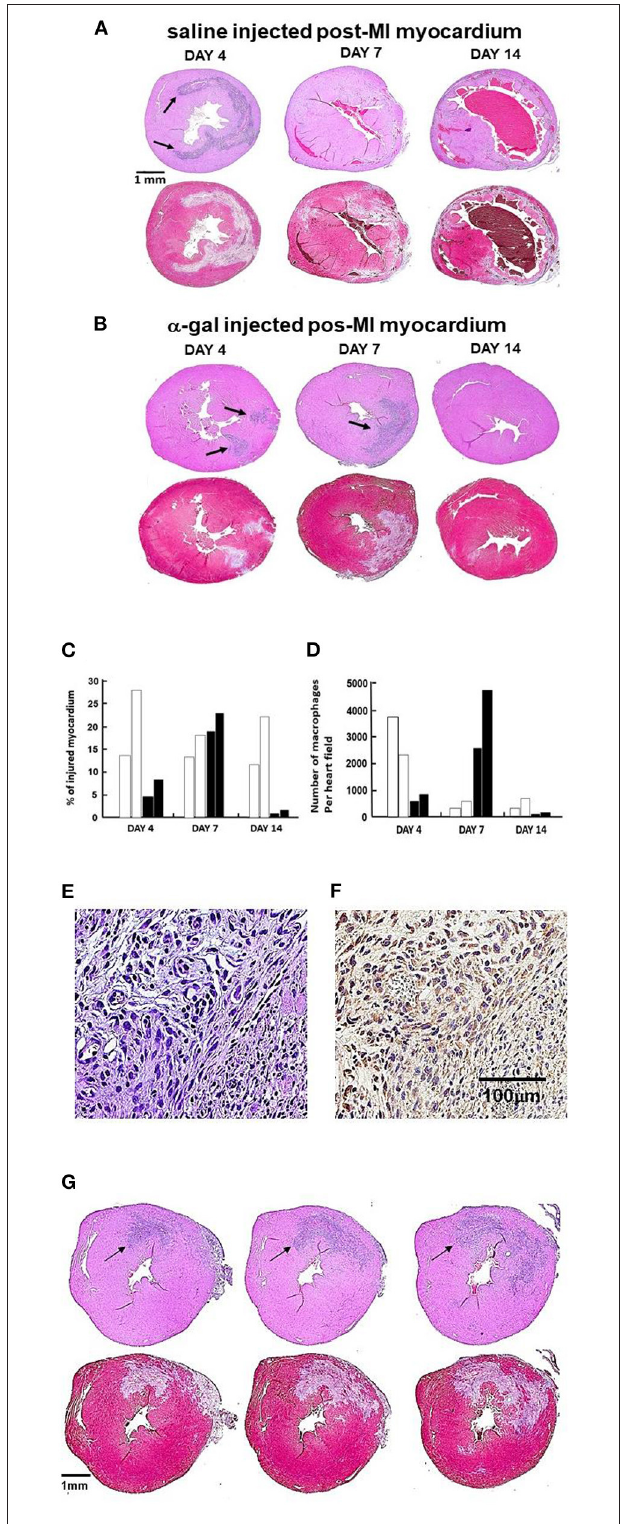
FIGURE 5 | Post-MI injury and macrophage infiltration at 4, 7, 14 days post-MI in controls and treated mice ( n = 2 at each time point). In (A,B) ,